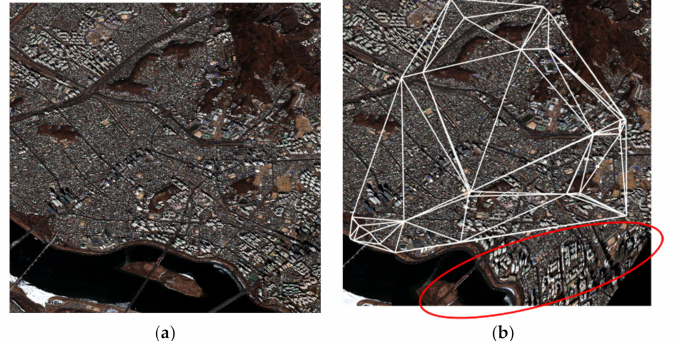
Figure 1. Example of severe distortion occurring outside the triangular region, caused by applying piecewise linear (PL) transformation: ( a ) Before warping and ( b ) after